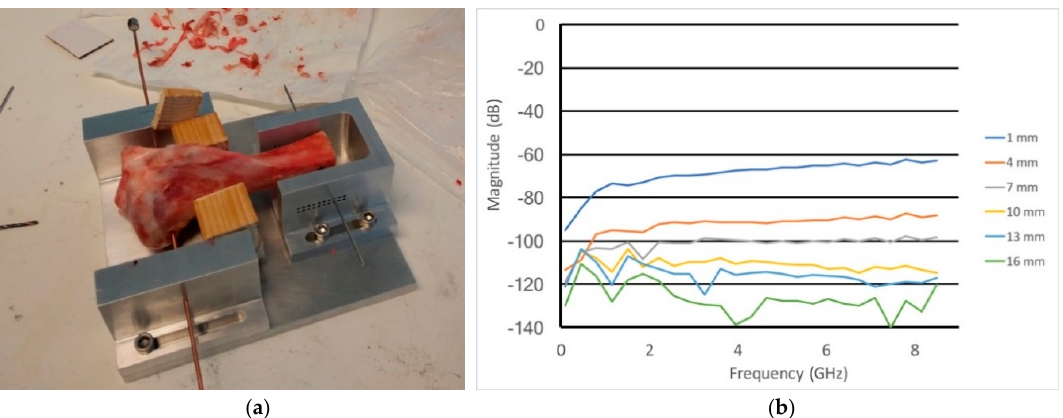
Figure 6. ( a ) Photograph of the bovine bone sample in the measurement test fixture with the coaxial cables extending outward from either side and ( b ) magnitude measurements for the bone sample over a range of separation distances.